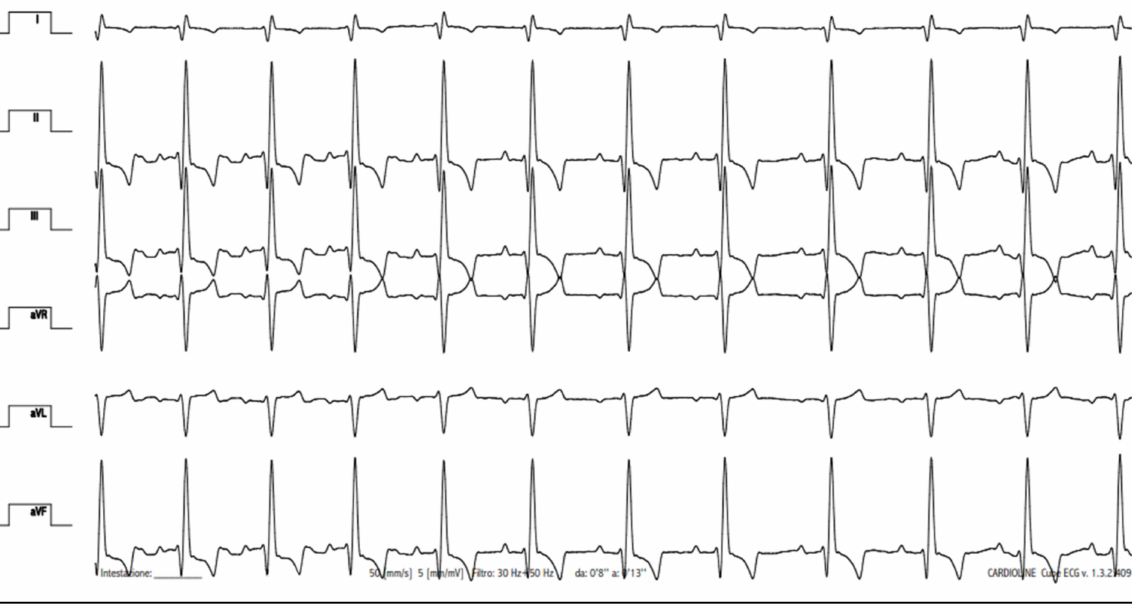
Figure 2. Six-lead electrocardiographic tracing. Sinus rhythm is evident. Paper speed = 50 mm/s; 1 cm = 2